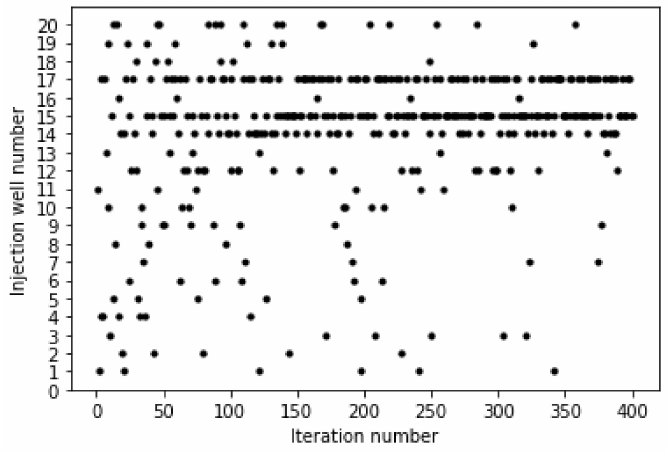
Figure 15. Well numbers selected as candidate injectors over 400 iterations through posterior sam- pling.